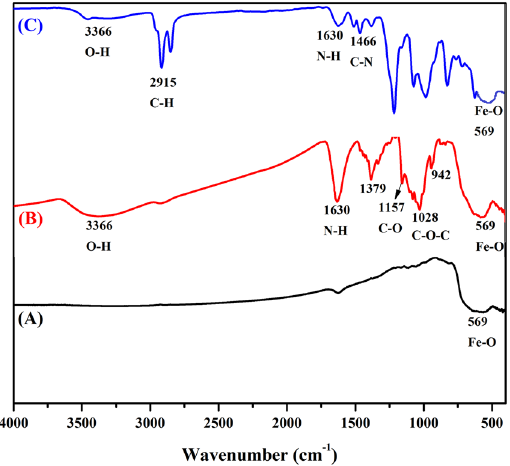
Figure 1. FT-IR spectra for ( A ) Fe 3 O 4 , ( B ) β -CD-EDTA-Fe 3 O 4 , and ( C ) β -CD-EDTA-Fe 3 O 4 /CPT